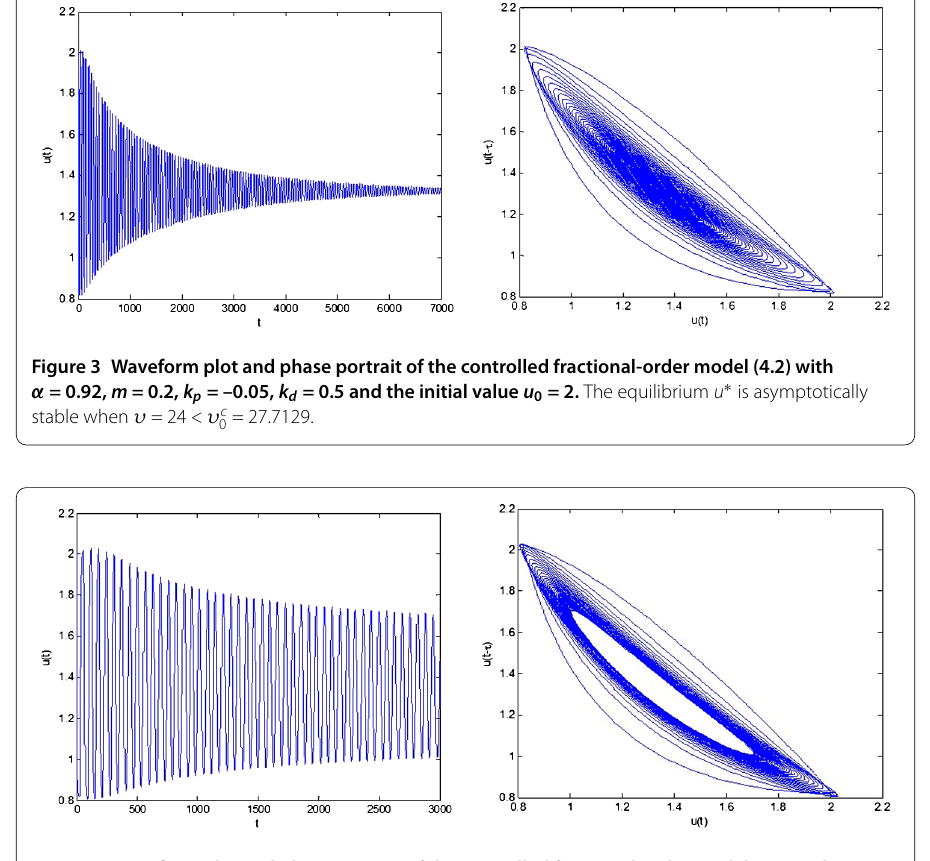
Figure 4 Waveform plot and phase portrait of the controlled fractional-order model (4.2) with α = 0.92, m = 0.2, k p = –0.05, k d = 0.5 and the initial value u 0 = 2. A Hopf bifurcation occurs and the periodic oscillation bifurcates from u ∗ , where υ = 30 > υ c 0 =